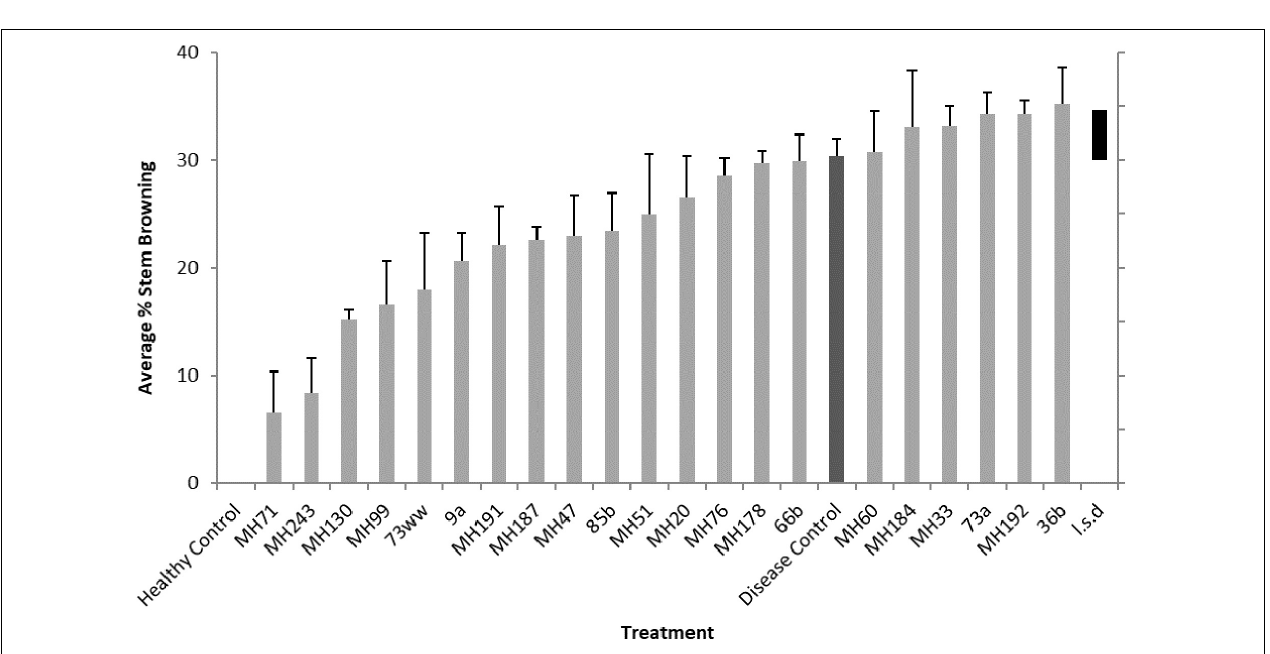
FIGURE 5 | Example photos of seedling disease protection assays. Wheat cv. Tamaroi seeds were coated with xanthan gum containing spores of a treatment Actinobacteria (or xanthan gum alone for controls) prior to germination. Seedlings were challenged with a 2 mL of a broth containing mycelia of F. pseudograminearum CS5642 (at the 2-leaf stage of growth). Pink/red discoloration and stem browning indicate F. pseudograminearum infection. (a) healthy control; (b) disease control; (c) seeds treated with ineffective inoculant 66b; (d) seeds treated with highly beneficial MH71.